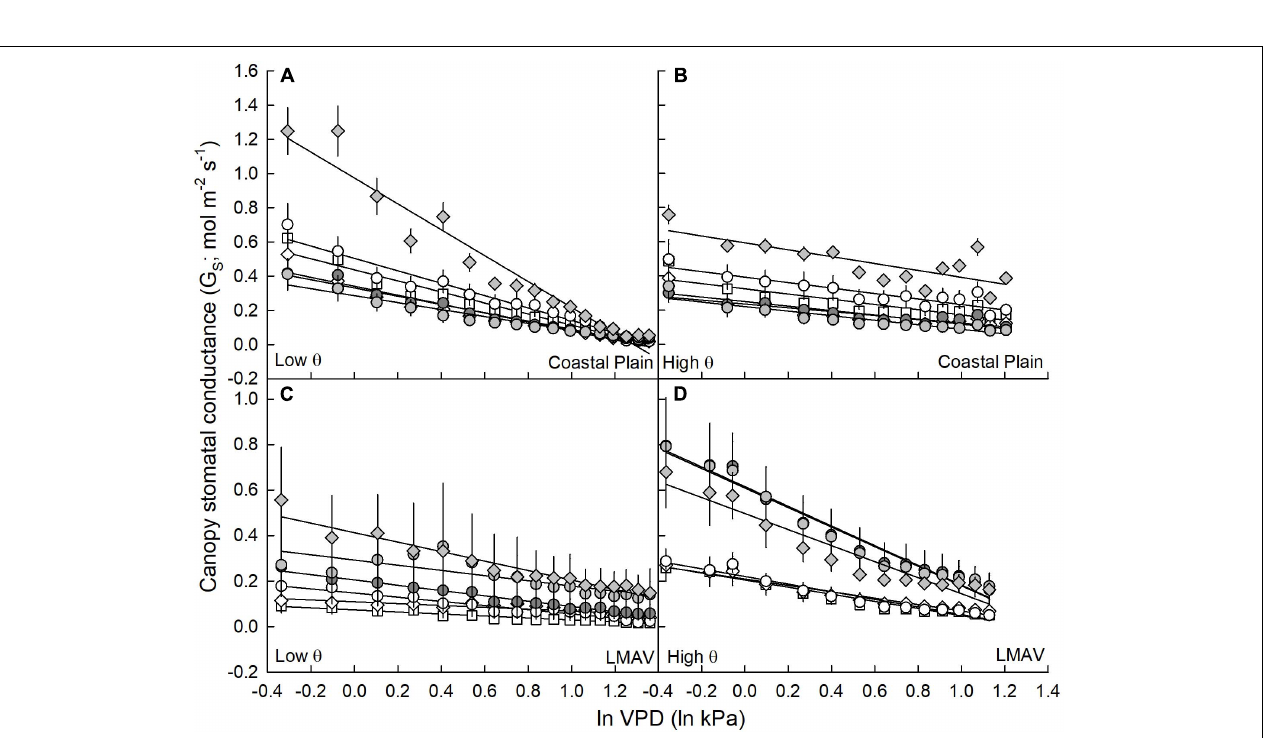
FIGURE 2 | Canopy stomatal conductance (G S ; mol m − 2 s − 1 ; mean and SE) vs. volumetric soil moisture content ( θ ; cm 3 cm − 3 ) for eastern cottonwoods (D × D) including varietals 110412 (white circles), S7C8 (white diamonds), and ST66 (white squares) and hybrid poplars in the P. deltoides × P. maximowiczii taxa (D × M) including 6329 (light gray circles) and 8019 (light gray diamonds) and the P. trichocarpa × P. deltoides taxa (T × D) including varietal 5077 (dark gray circles) at the (A) Coastal Plain and (B) LMAV sites.